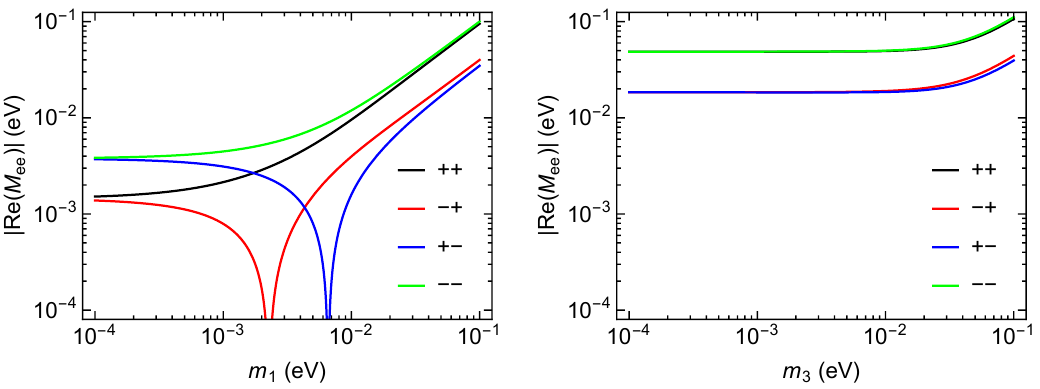
Figure 5 . The possible values of j Re( M (or IH) case for various combinations of (cid:26) (0) and (cid:27) (0) . The signs ++ ; (cid:0) + ; + (cid:0) and (cid:0)(cid:0) respectively stand for [ (cid:26) (0) ; (cid:27) (0) ] = [0 ; 0] ; [ (cid:25)= 2 ; 0] ; [0 ; (cid:25)= 2] and [ (cid:25)= 2 ; (cid:25)=